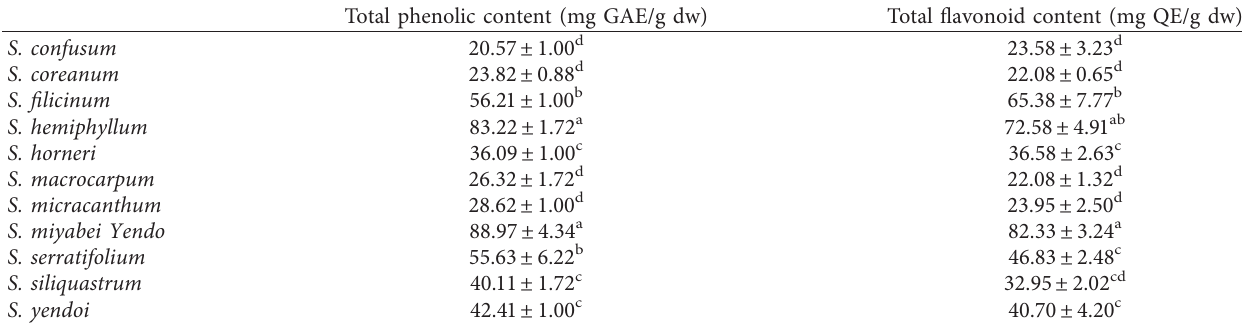
Table 1: Total phenolic and total flavonoid contents of Sargassum species.